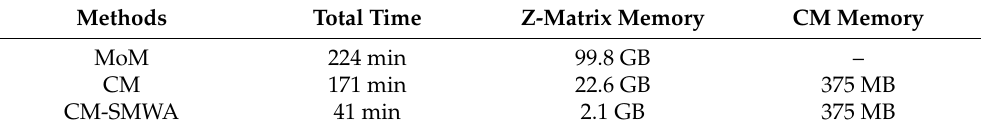
Table 5. Comparison of the CPU time and memory requirement of the different algorithms at 76